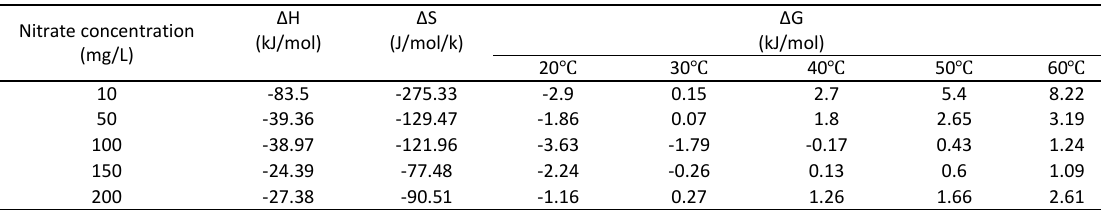
Table 4: Values of the thermodynamic parameters of nitrate adsorption by Mg-Al-LDH (4:1) in the concentraon of 10, 50, 100, 150 and 200 mg/L